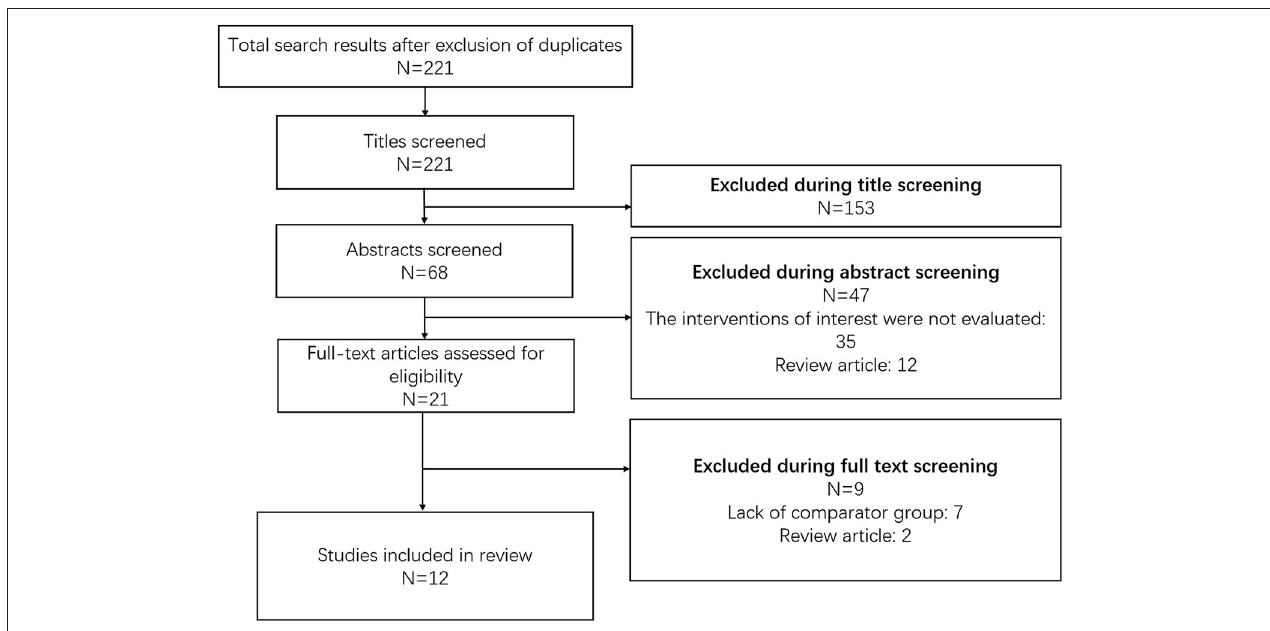
FIGURE 1 | The selection process of the studies included in the